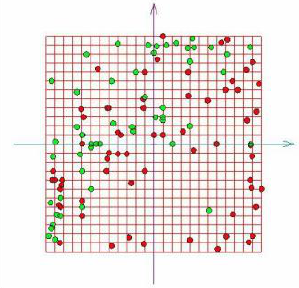
Figure 11. Extension of elastic map for 10-dimensional attribute space